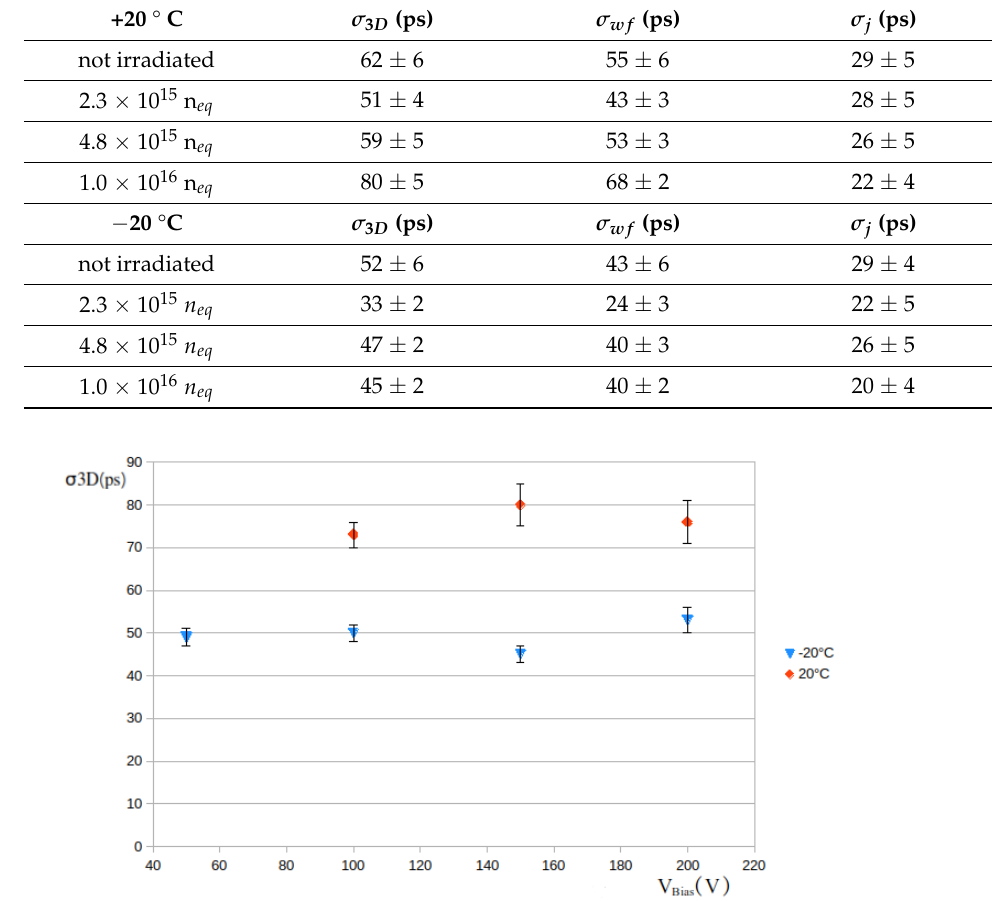
Table 3. Time resolution measurements at 150 V for different radiation doses.